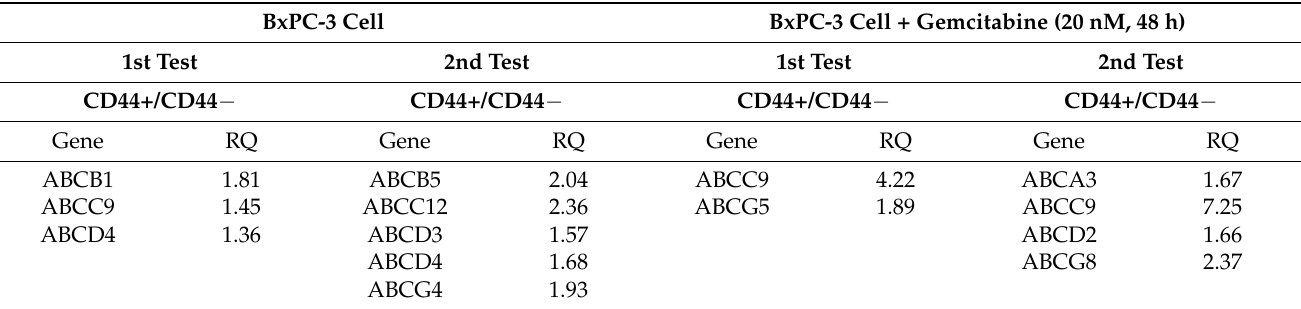
Table 2. ABC transporters with expression altered by >1.5 fold in CD44+. cells compared with CD44 − cells (RQ: Relative Quantity RNA). BxPC-3 Cell BxPC-3 Cell + Gemcitabine (20 nM, 48